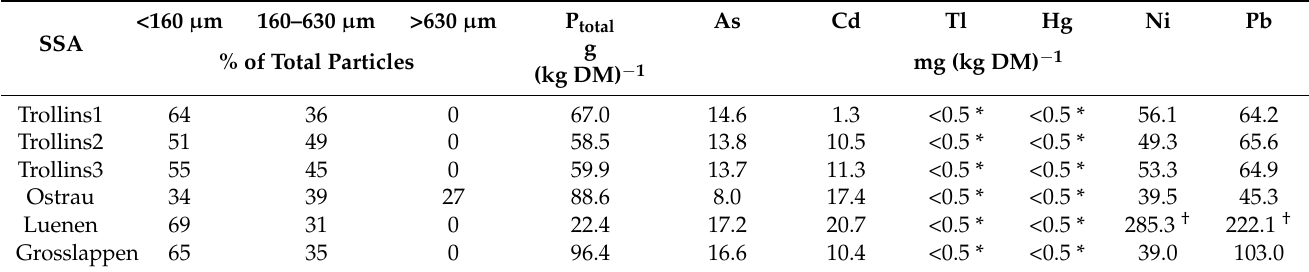
Table 2. Particle size distribution of the SSAs expressed as a percentage of the total number of particles. The total content of P is indicated in g (kg dry matter (DM)) − 1 and heavy metals in mg (kg DM) − 1 of the